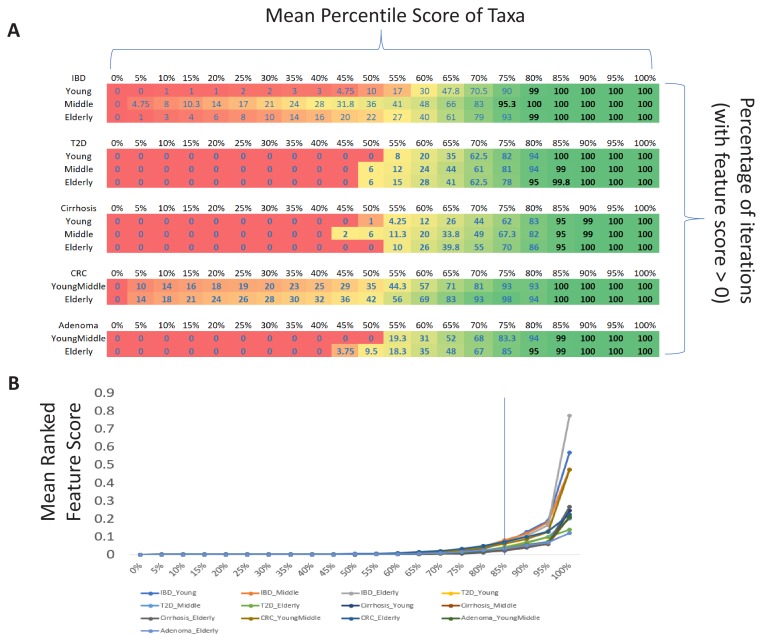
Variation of feature importance scores of the taxa across the iterative Random Forest models.(A) Frequency at which taxa with feature importance scores in different percentile were identified as markers (Mean Decrease of GINI > 0) in the iterative RF models for each of the 13 disease – age-group scenario. For all the 13 disease-age-group scenario, taxa features with scores above 85 percentile were identified as markers in at least 95% of the iterations. (B) Variation of the mean feature importance scores of taxa in various percentiles. For most of the 13 scenarios, the mean feature importance scores remain stable and low till the 80% mark and start increasing only after that. Given these two observations, the percentile threshold of 85 was identified to filter the top disease associated features.